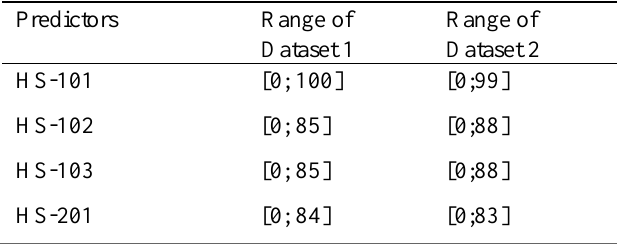
Comparison of Analysis for Technical Courses